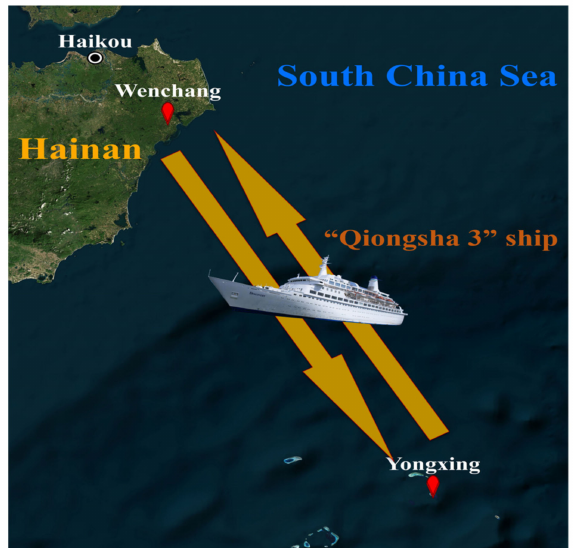
Figure 2. Marine area for the conduct of the over − the − horizon propagation experiment.